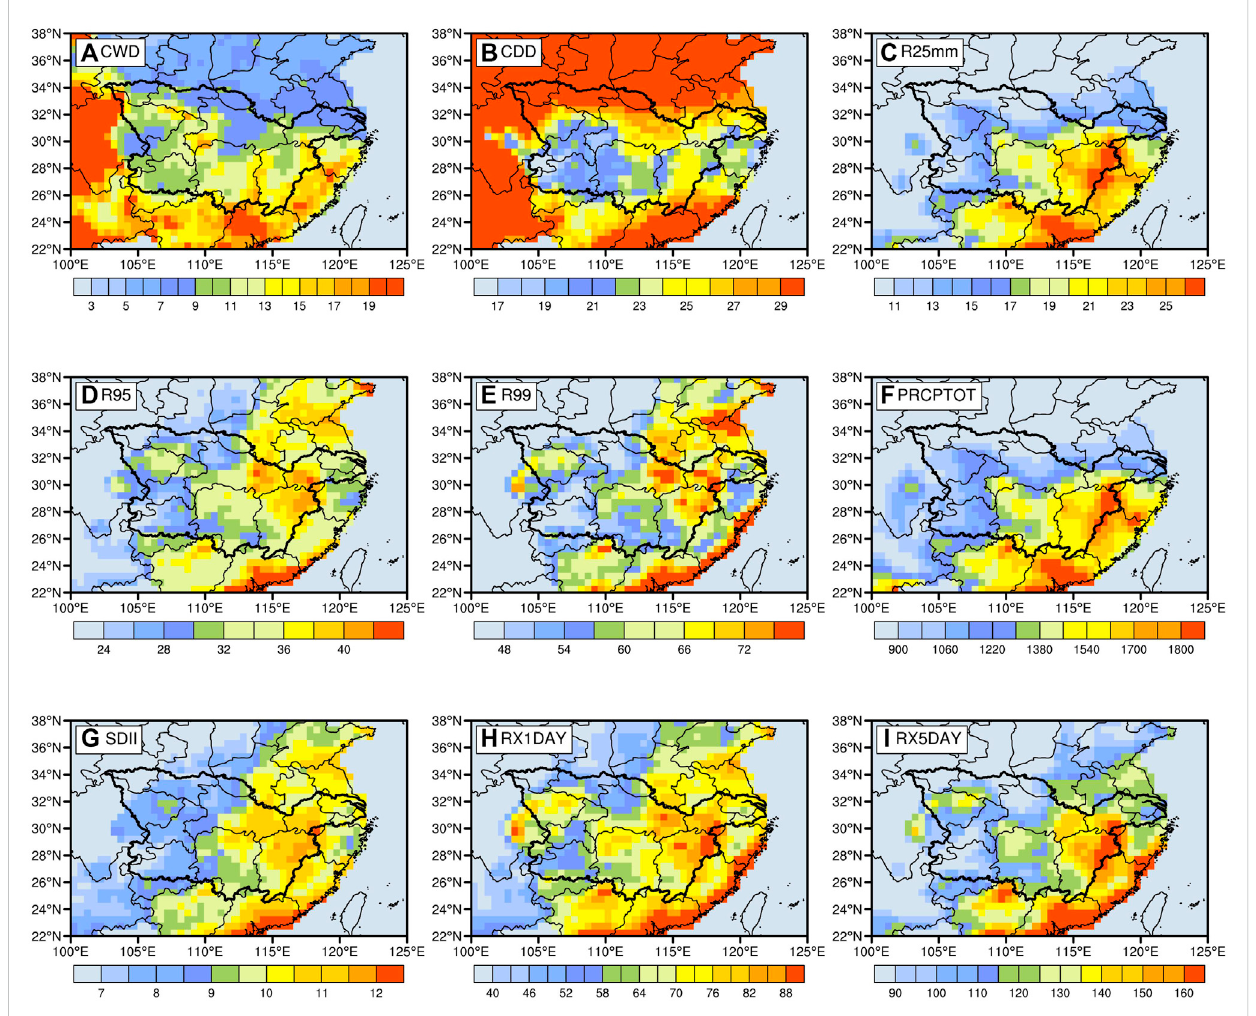
FIGURE 3 Spatial distributions of annual mean precipitation indices over the MLYR from 1979 to 2015. The area surrounded by the thick black line is the MLYR. (A) CWD; (B) CDD; (C) R25mm; (D) R95; (E) R99; (F) PRCPTOT; (G) SDII; (H) RX1DAY; (I) RX5DAY.